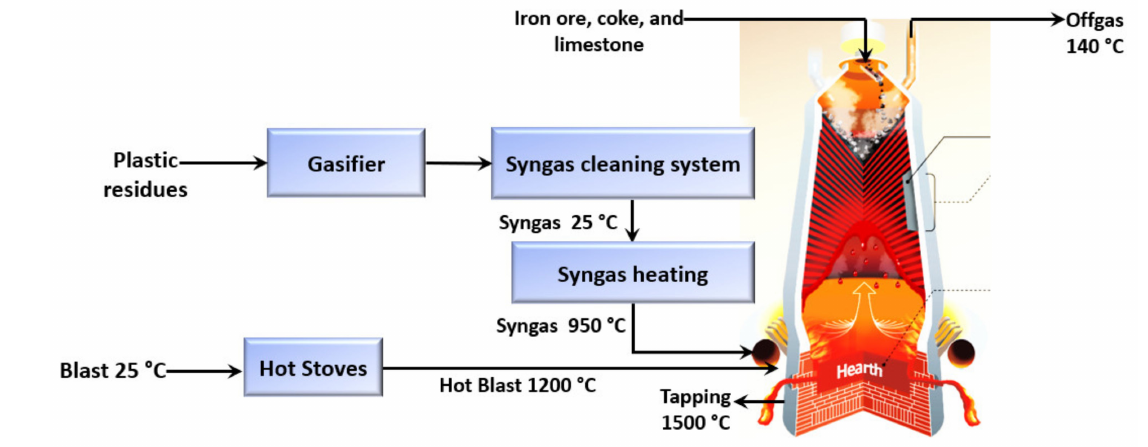
Figure 13. Principal layout of syngas injection into the BF [39].